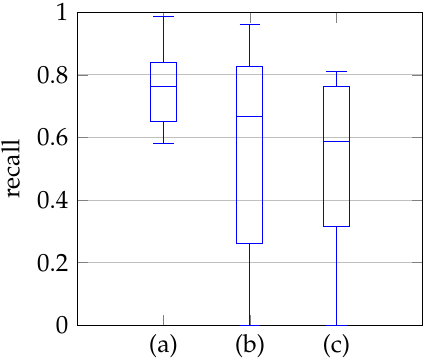
Figure 12. Recall of mitral valve detection over ten videos for Windowing ( a ), detection by Dukler et al. ( b ) and detection by Corinzia et al. ( c ).